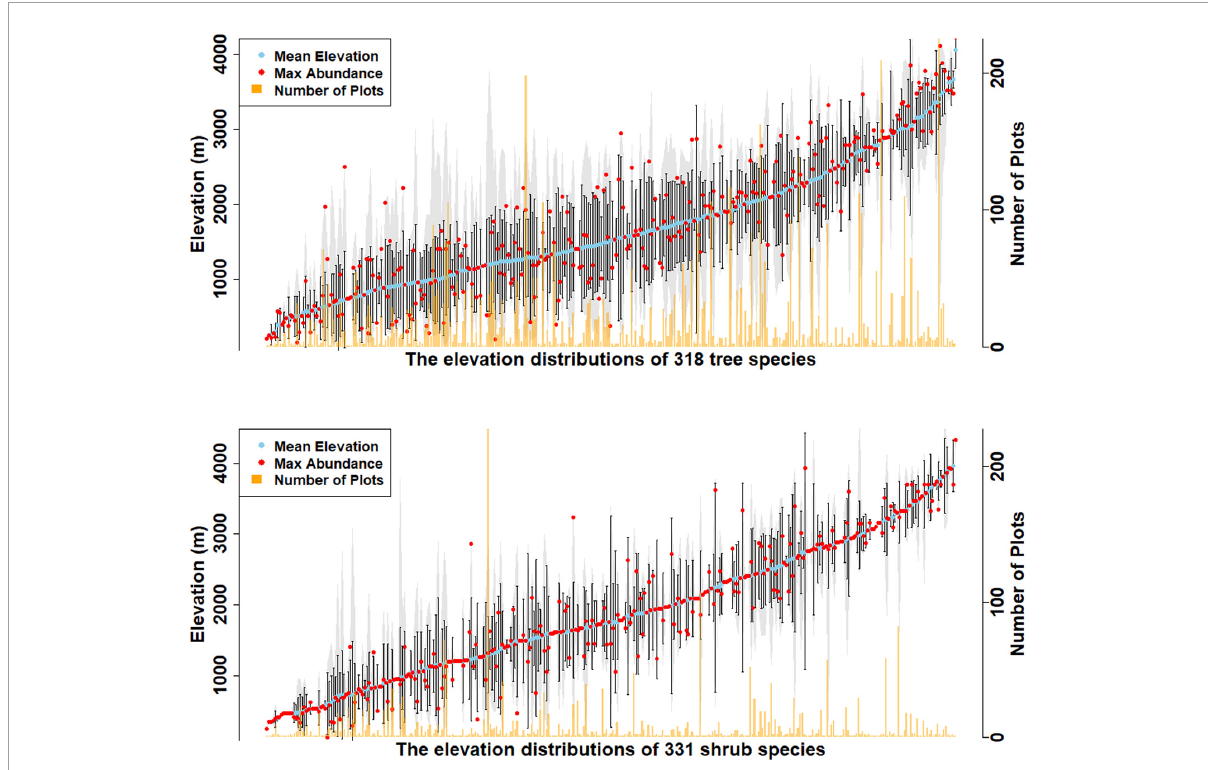
FIGURE2 Elevational distribution of tree and shrub species recorded in the survey. The blue dots show the mean elevation for each species, red shows location of elevation of maximum abundance, and tan shows the number of plots in which each species was found. Vertical black lines are the standard deviation of elevation from the mean of each species, while the gray areas show the entire recorded elevation range of each